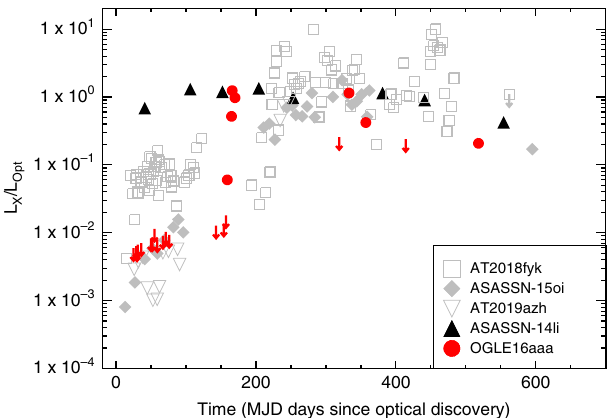
Fig. 4 Comparison of OGLE16aaa with other TDEs in the evolution of optical to X-ray luminosity ratio. The optical luminosity refers to the integrated blackbody luminosity from the SED fi ttings to the Swift UVOT photometry. For epochs where only UV observation at one band is available ( t = [300, 490] days), we extrapolated the UV luminosity to the blackbody luminosity by assuming a constant temperature evolution since t = 150 days. For the X-ray non-detections, the corresponding 3 σ upper limits are given. Red symbols represent the luminosity ratios of OGLE16aaa at different epochs. For comparison, we also plotted the ratios for other X-ray bright TDEs from 5,6,39 , as noted in the legend. ASASSN-14li 17 is the only TDE that shows nearly constant optical to X-ray luminosity ratios since discovery. Although OGLE16aaa appears to follow the evolution trend as other TDEs, the time of rise to peak is